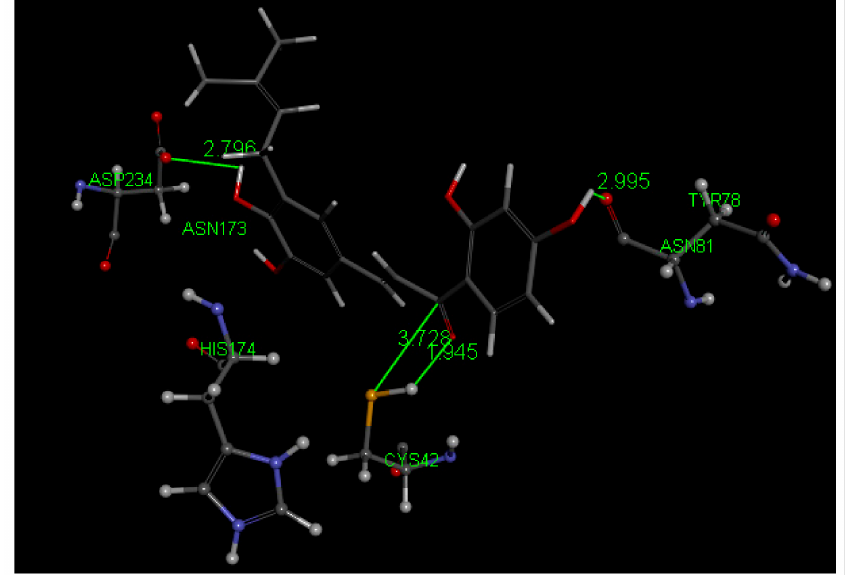
Figure 25. Pose 3, after docking 5-Prenylbutein ( 4 ) in the 3BPF receptor. 3.3. RRDE Antioxidant Activity Assay of 2 (cid:48) ,4 (cid:48) -Dihydroxy-3,4-dimethoxychalcone (DHDM) and Butein The effects of increasing concentrations of DHDM and Butein on the superoxide redox reaction are demonstrated through current density against potential curves plotted in Figures 29 and 30